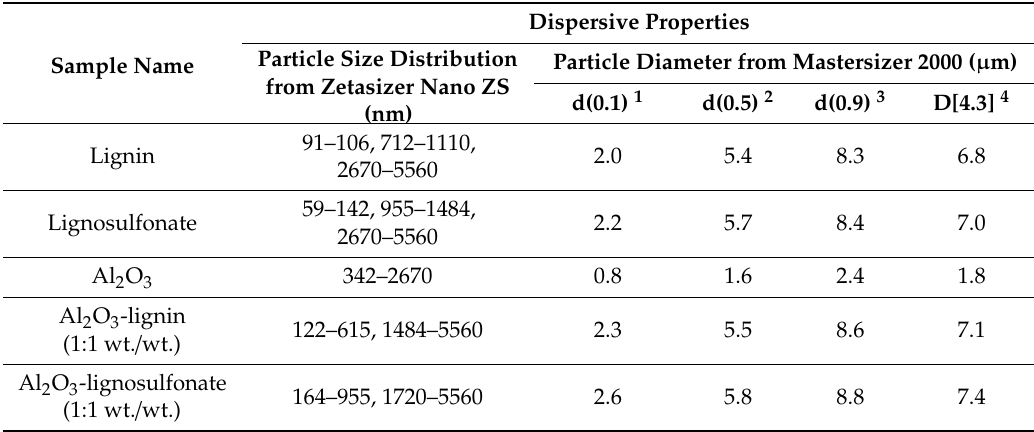
Table 1. Dispersive properties of lignin, lignosulfonate, alumina and inorganic-organic hybrid